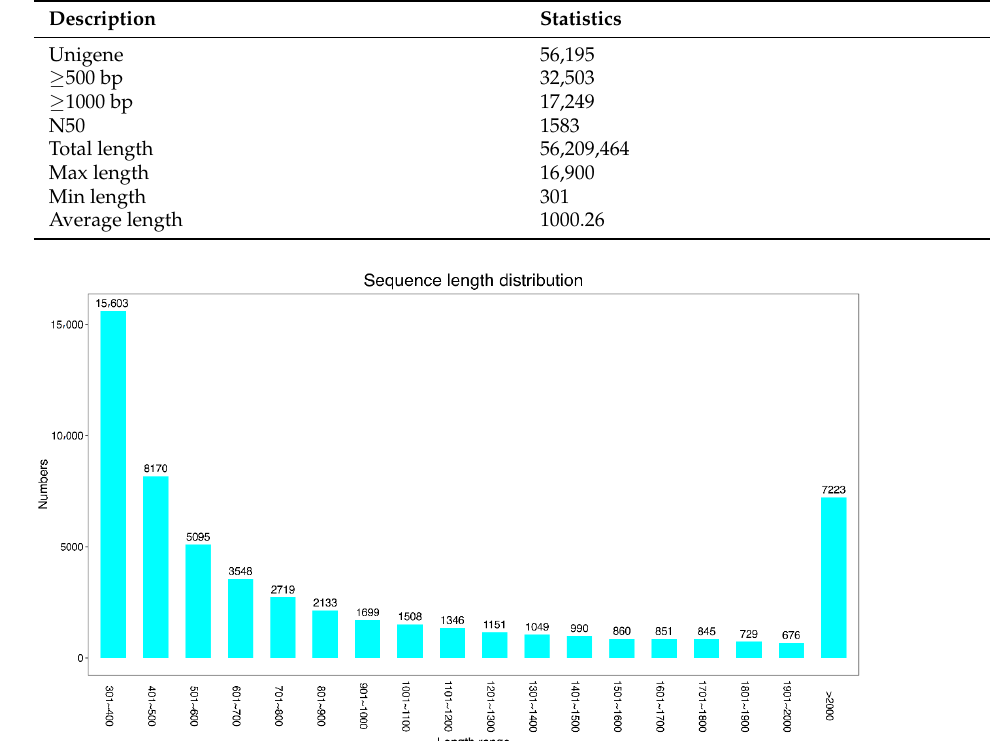
Figure 1. Unigenes from the de novo transcriptome assembly of Chinese yam. The bars represent different sizes and number of unigenes obtained using transcriptome analysis of leaf, stem, and root tissues of Chinese